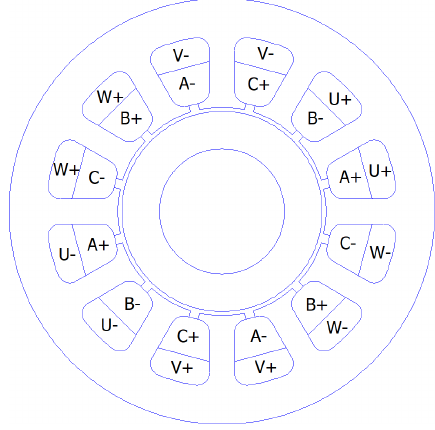
Figure 2. Bearingless induction motor winding